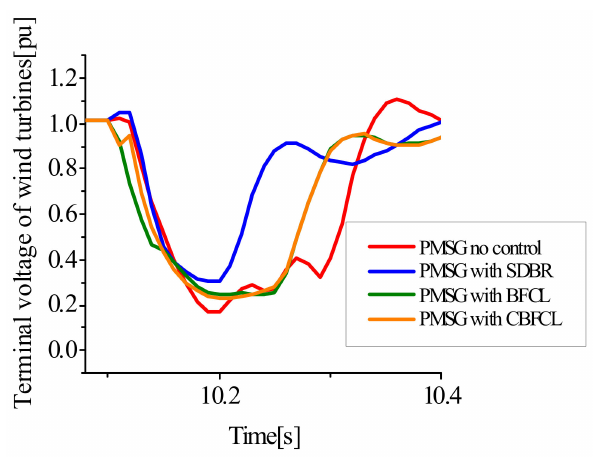
Figure 26. Terminal voltage of PMSG wind